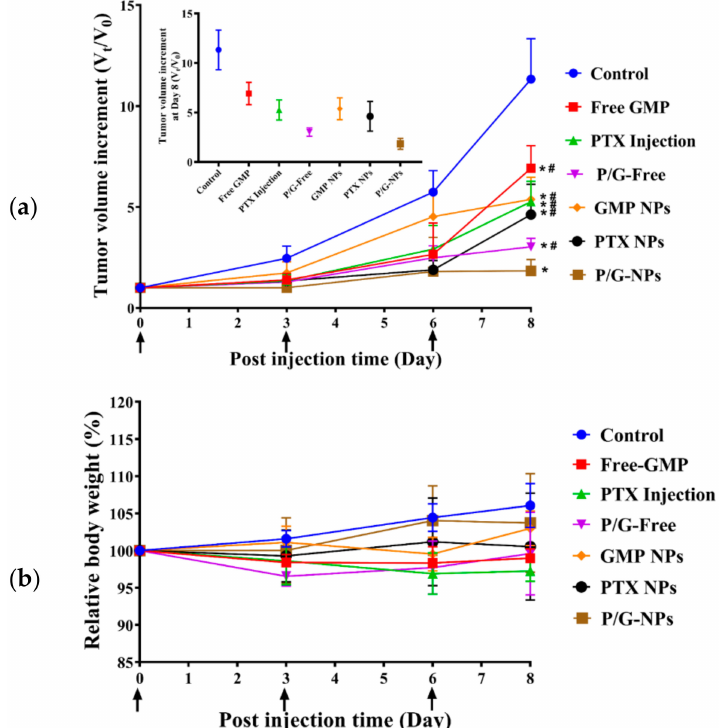
Figure 6. ( a ) Tumor growth inhibition effects of different formulations on MCF-7 tumor bearing mice. Free GMP, PTX Injection, P/G-Free, GMP NPs, PTX NPs, and P/G-NPs were administered intravenously every third day, for a total of three injections, as indicated by arrows. Data are mean ± SD. Statistics are as follows: * p < 0.05 vs Control; # p < 0.05 vs P/G-NPs; there is no significant difference among groups marked with “#”, n = 5; ( b ) The curve of relative body weight of every group ( n =